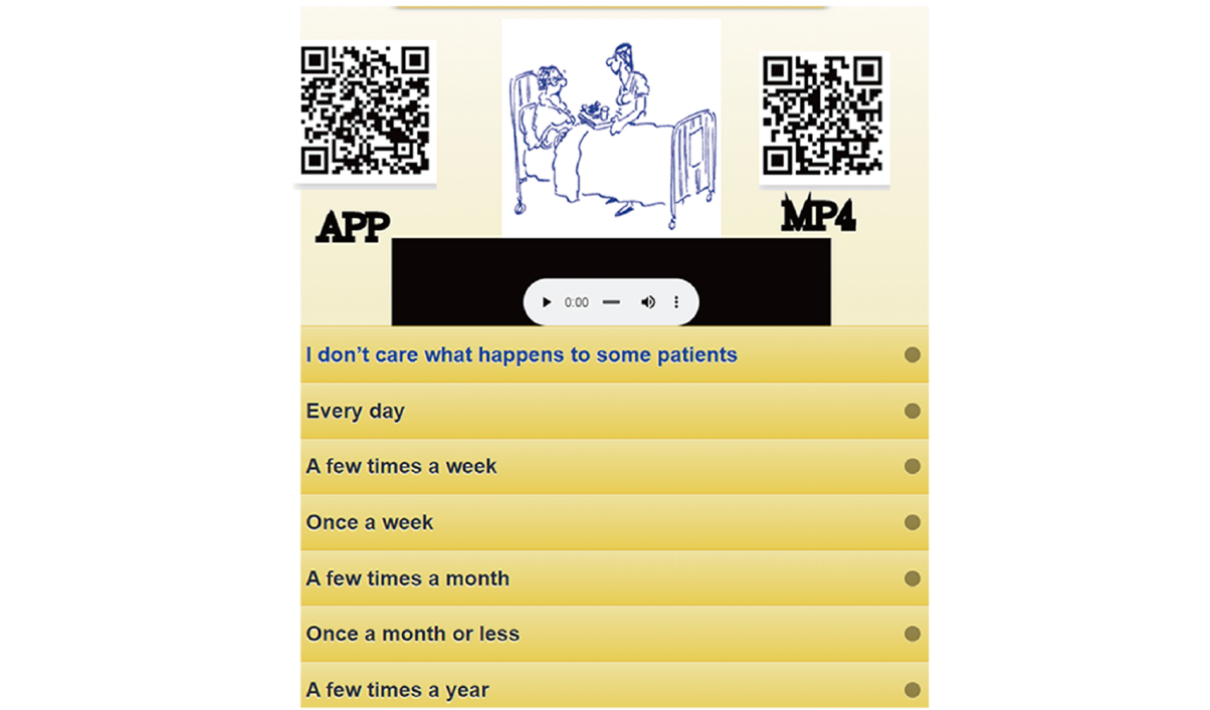
Figure 4. Screenshot of the mobile phone